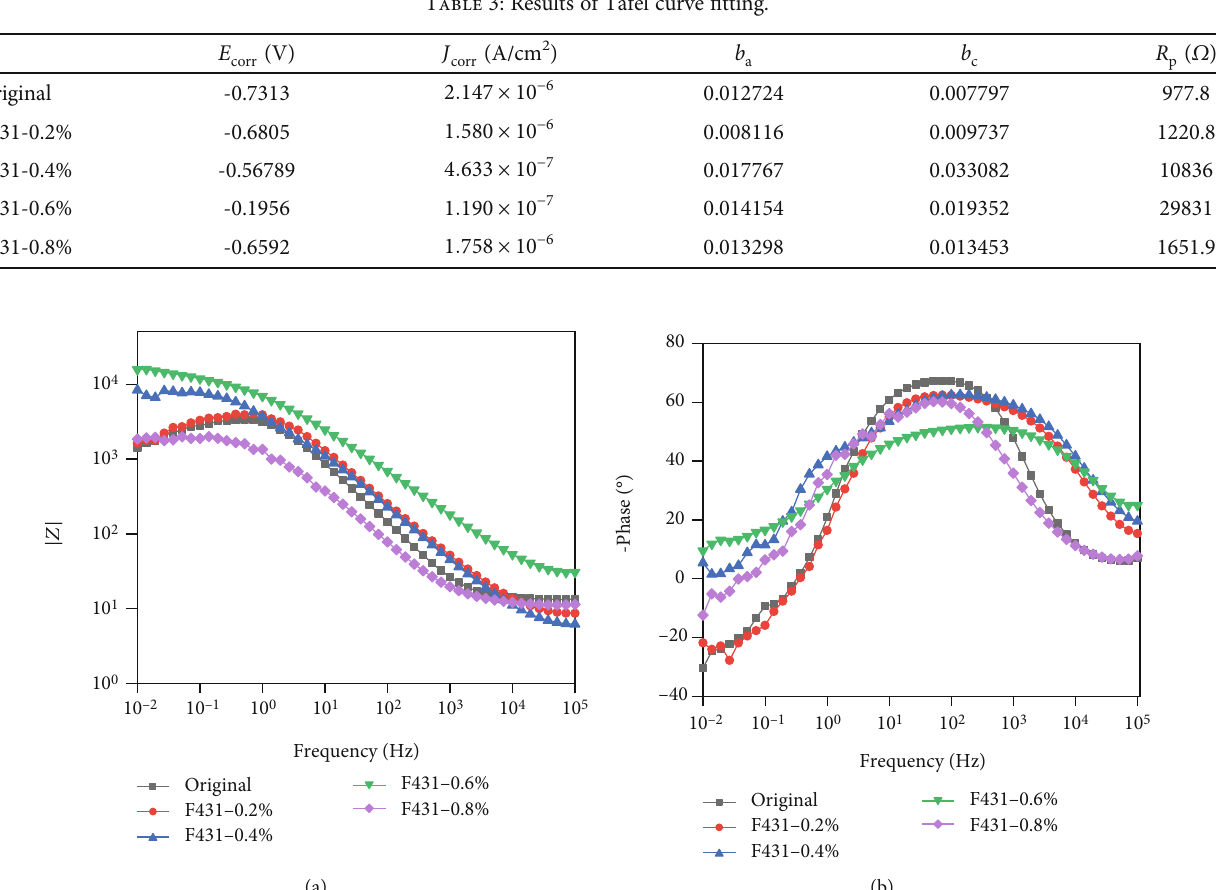
Table 3: Results of Tafel curve fi tting.